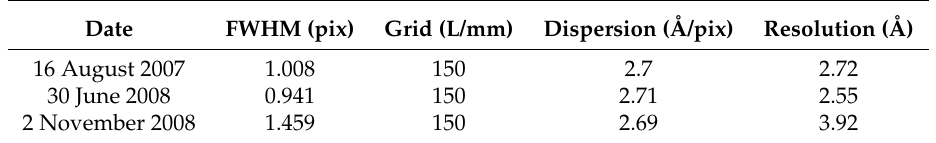
Table 3. Instrumental resolutions used in the observations. Different dispersion values associated with the same grid are due to the collimator calibration.